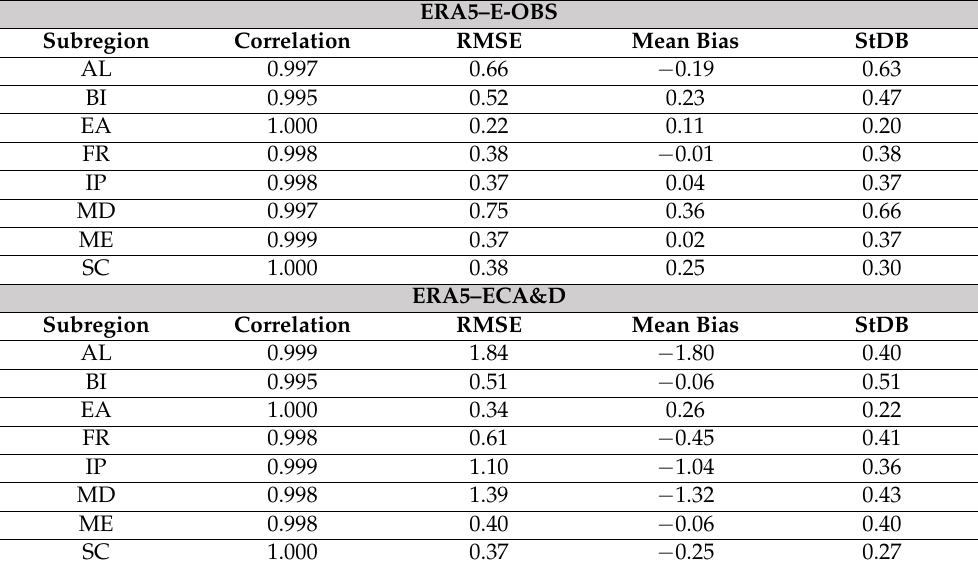
Table 1. Correlation RMSE, mean bias, and Standard Deviation Bias (StDB) between the ERA5 dataset and E-OBS, and daily observation of ECA&D stations. Annual statistics are given for mean temperature for the eight European